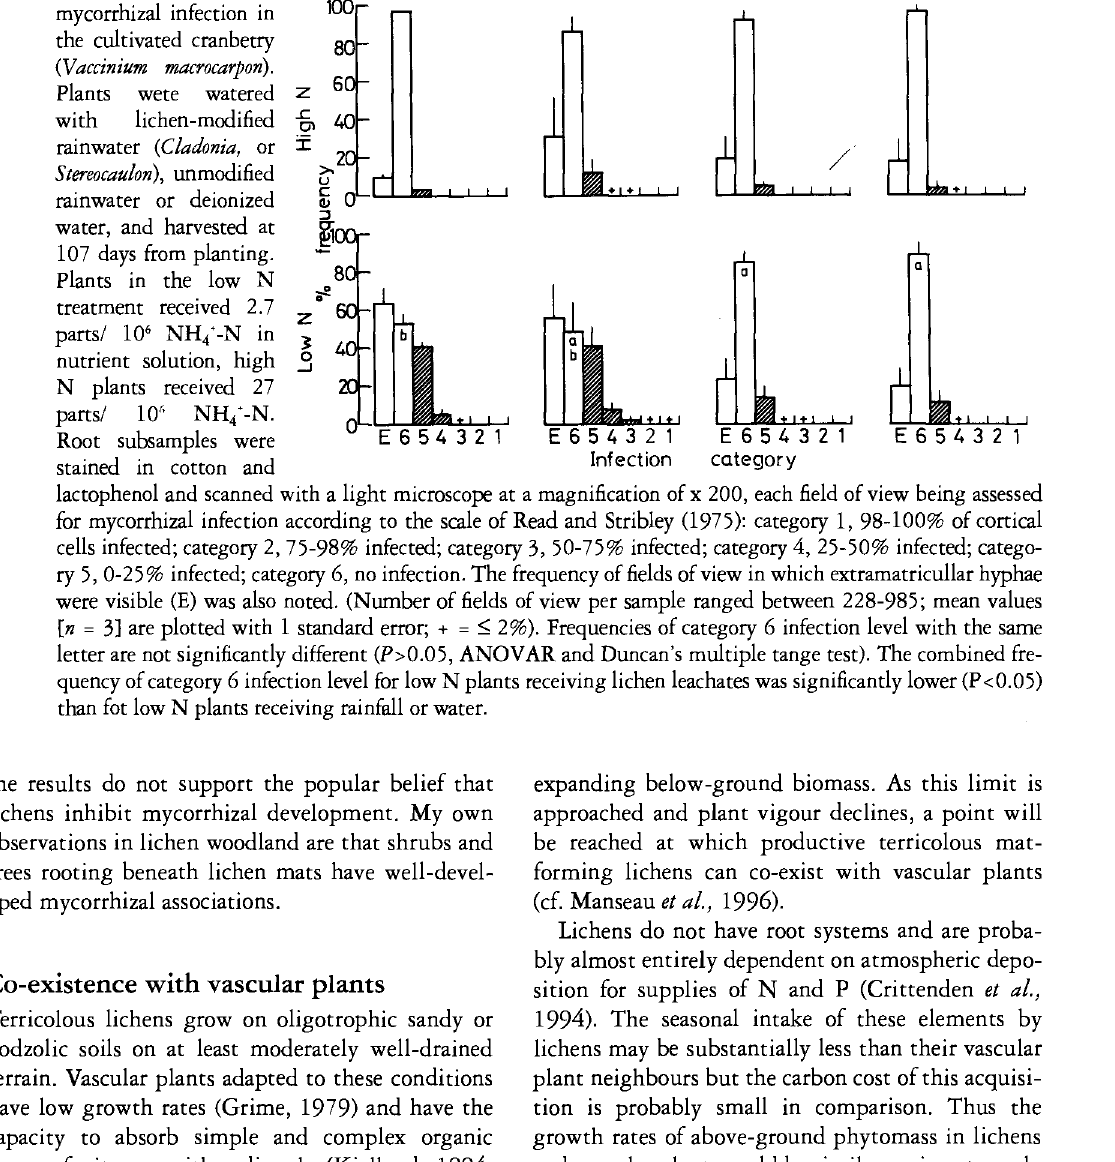
Fig. 2. The effect of lichens on mycorrhizal infection